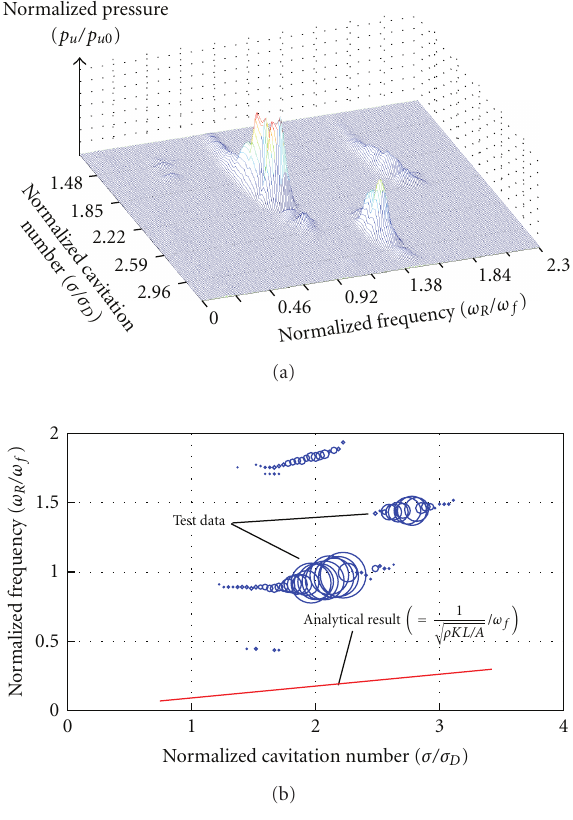
Figure 2: (a) FFT analyses of pressure fluctuation at inlet of the turbopump. (b) Analytical result by inertia model and experimental result of pressure fluctuation at inlet of turbopump. (The size of the bubbles indicate the amplitude of the pressure